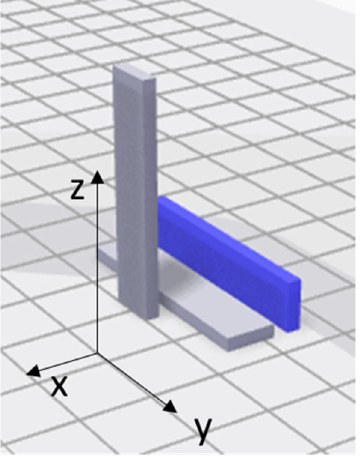
Figure 2. Printing orientations for the tested samples.